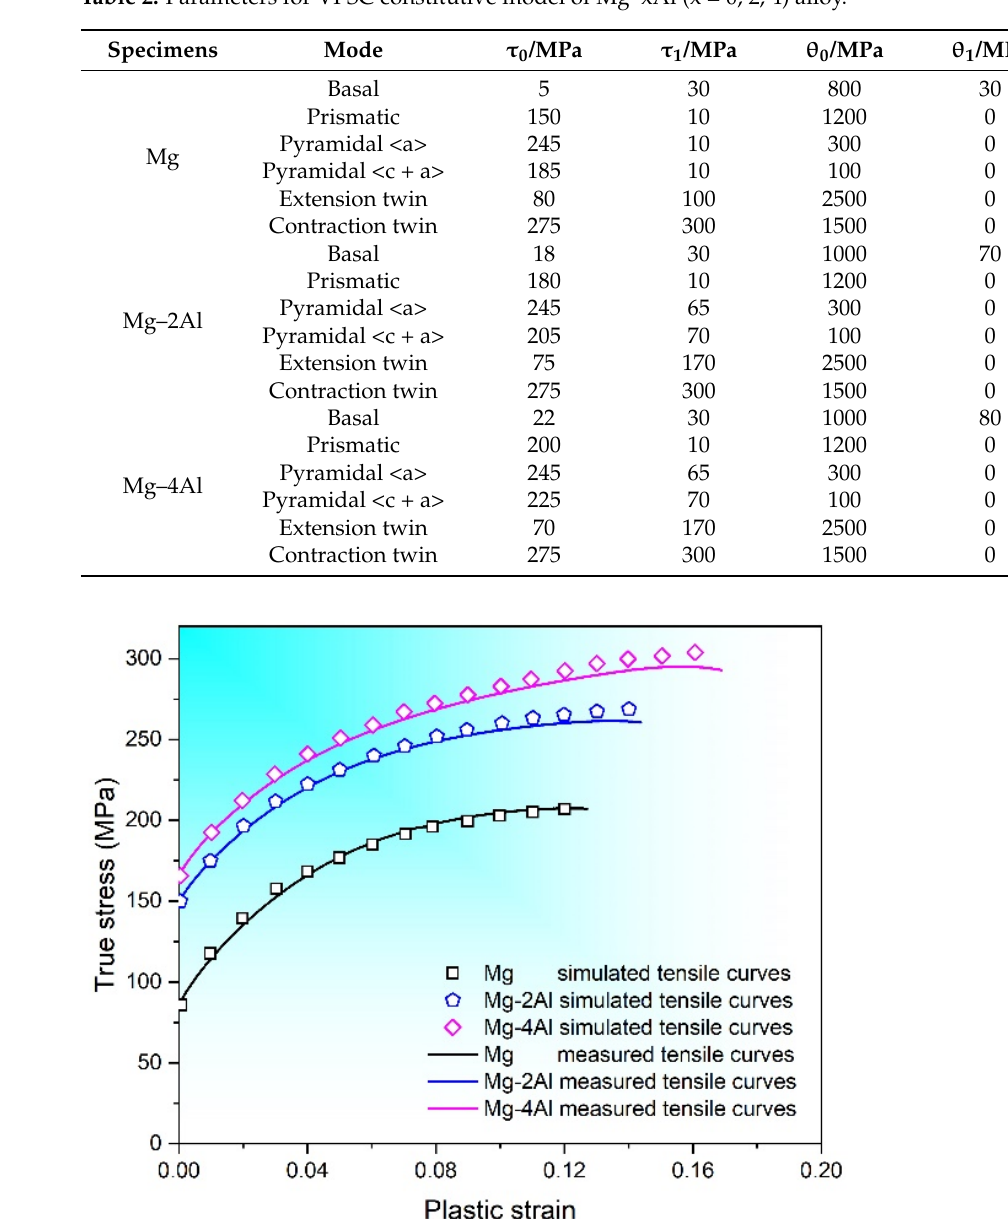
Table 2. Parameters for VPSC constitutive model of Mg–xAl (x = 0, 2, 4) alloy.